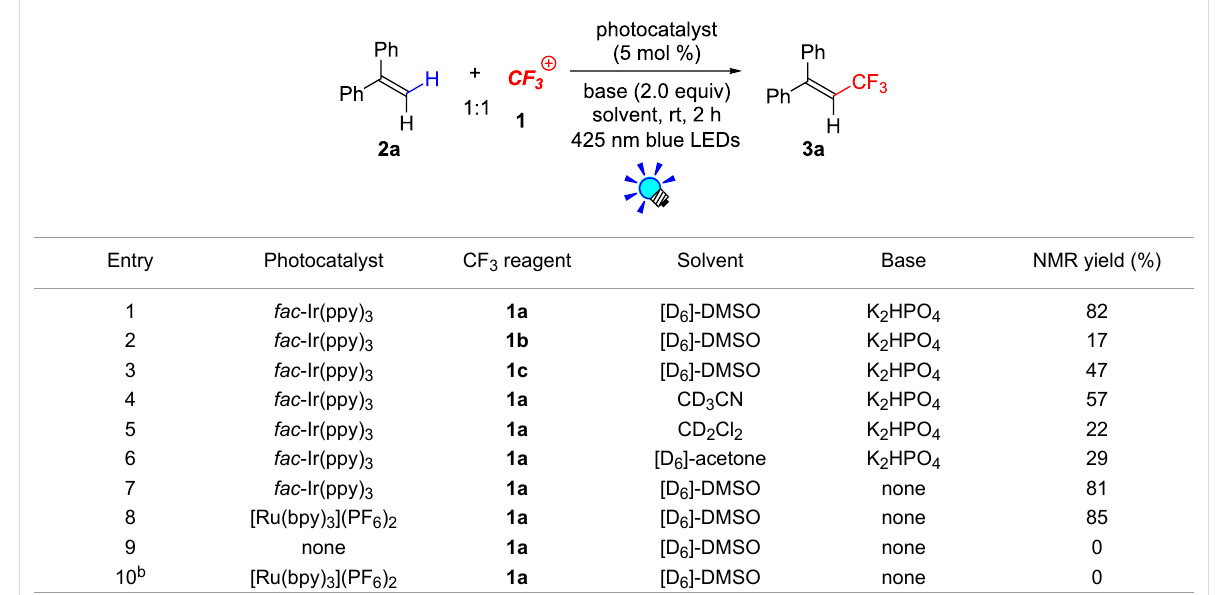
Table 1: Optimization of photocatalytic trifluoromethylation of 1,1-diphenylethene 2a .